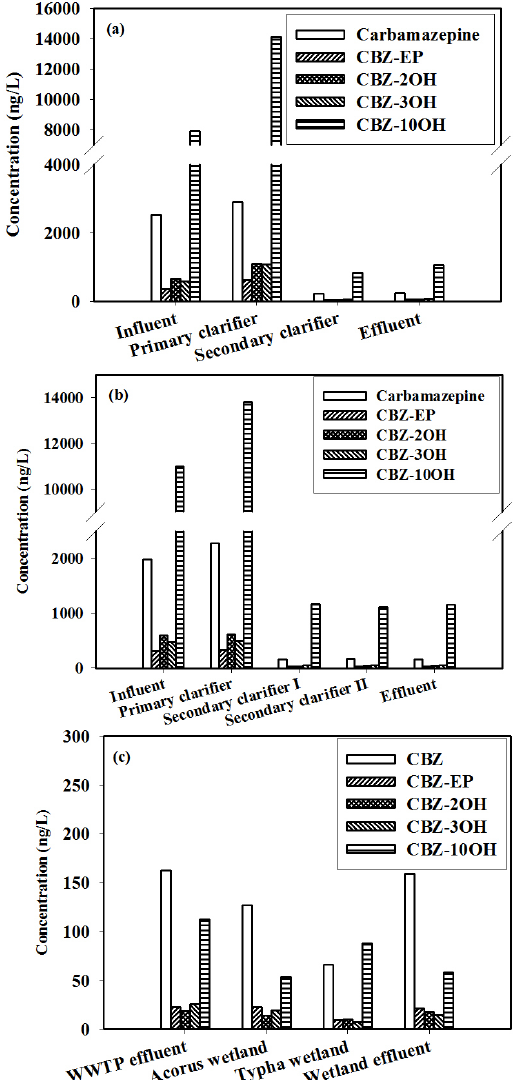
Figure 1. Transformation of ibuprofen in di ff erent WWTPs sys- tem: (a) Gwangju primary WWTP, (b) Gwangju secondary WWTP, (c) Damyang WWTP and constructed wetlands.